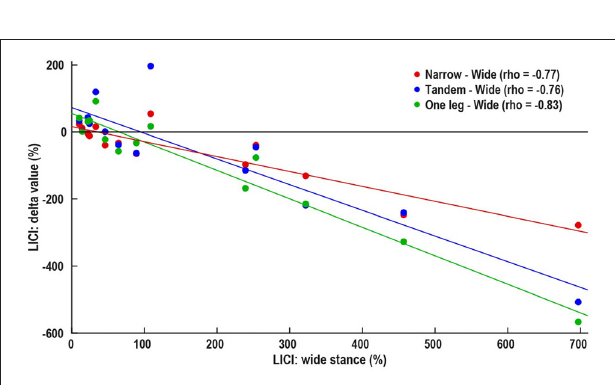
FIGURE 3 | Association between mediolateral (ML) center of pressure velocity and MEP.